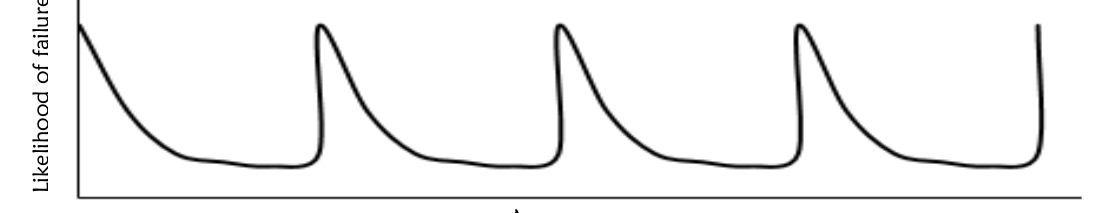
Figure 4: Lifetime likelihood of failure under reactive maintenance (Daley, 2008)